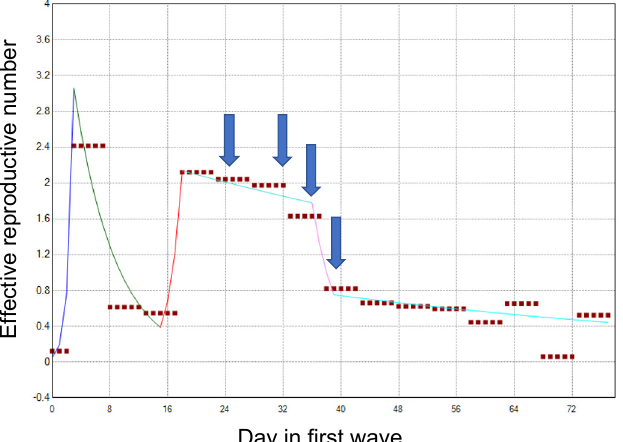
Figure A1. Joinpoint analysis during the first wave of coronavirus disease 2019 in Osaka, Japan. Closed squares indicate the effective reproductive number. The colored line indicates the regression line linking identified joinpoints. Blue arrows represent starting days of the four key interventions during the first wave. Day 0 corresponds to 24 February 2020.